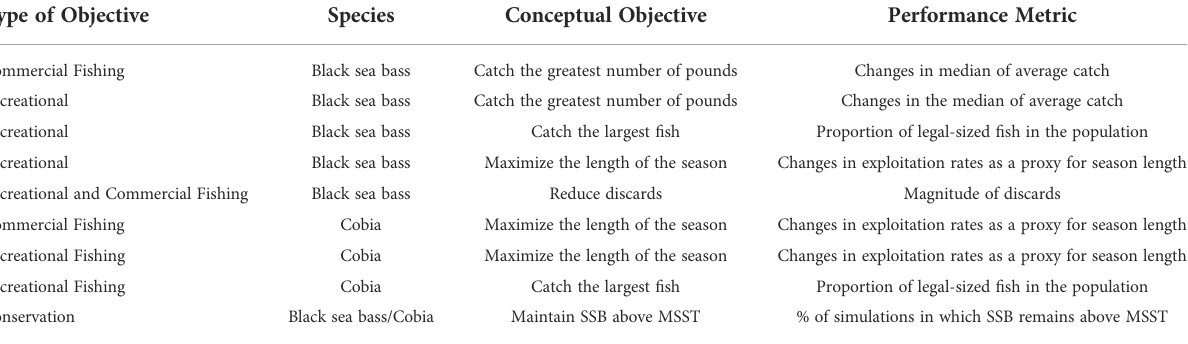
TABLE 3 Conceptual objectives and performance metrics derived from participants ’ responses to interview questions. Type of